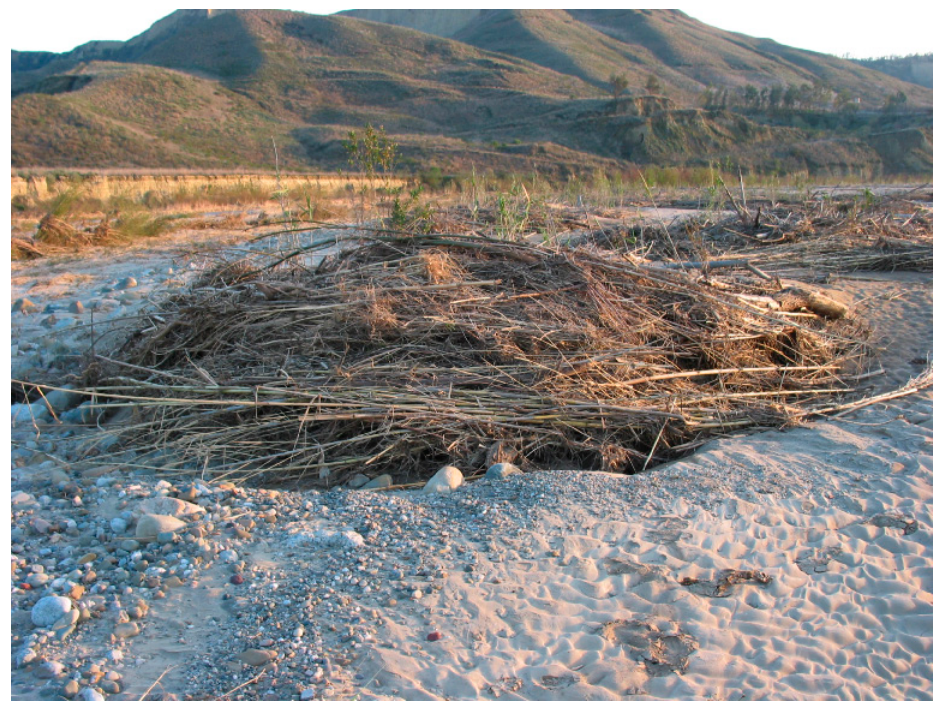
Figure 4. A. donax debris wrapped around and defending a small island from erosion in the Santa Clara River (S2) following a flood. The debris may later sprout and further defend the island.